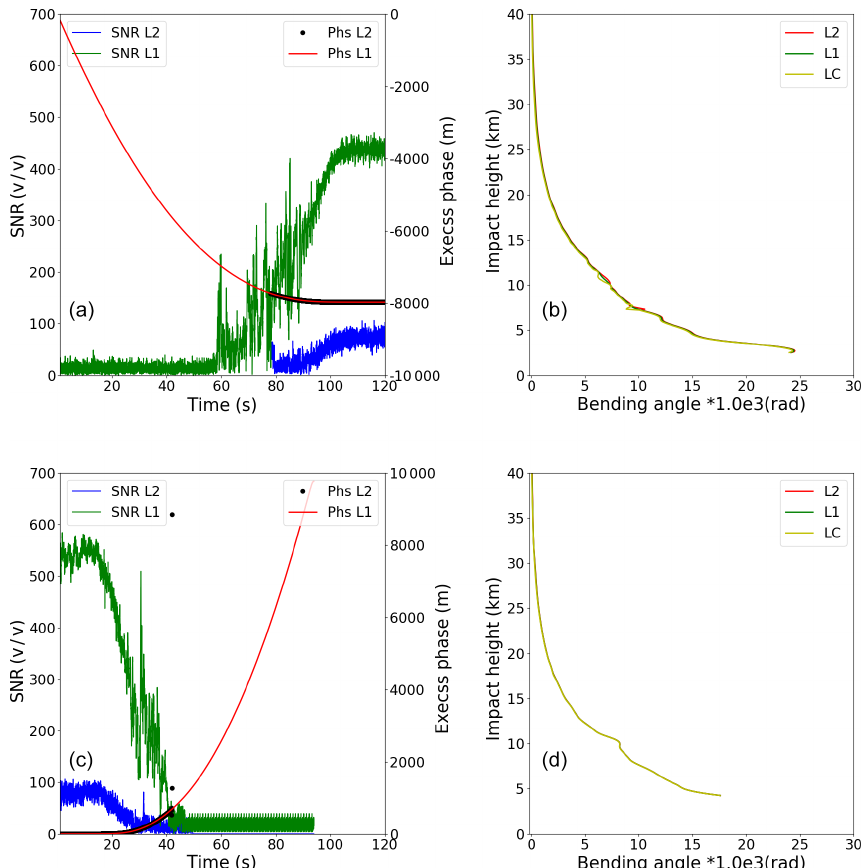
Figure 4. Two good cases – (a) an arising profile (FY3C_GNOSX_GBAL_L1_20170128_1138_AEG27_MS.NC) and (b) a setting profile (FY3C_GNOSX_GBAL_L1_20170128_1648_AEG31_MS.NC). Example L1 (red) and L2 (black) SNR and excess phase measured data. The resulting L1 bending angle (green), L2 bending angle (red) and corrected LC bending angle (yellow) profiles as a function of impact parameter computed using ROPP